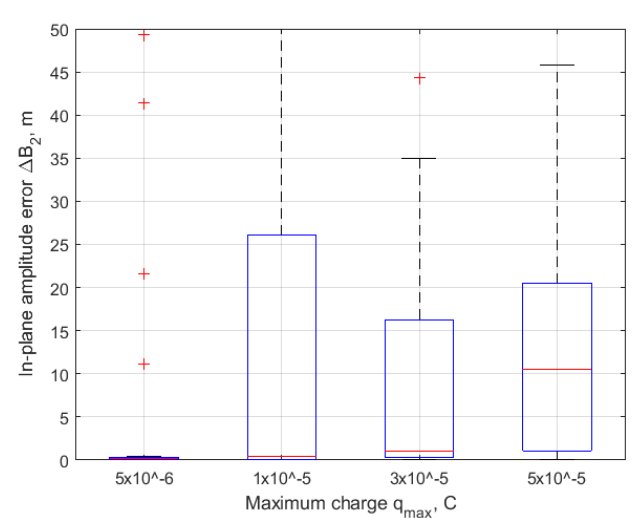
Figure 17. Mean error in B 2 after